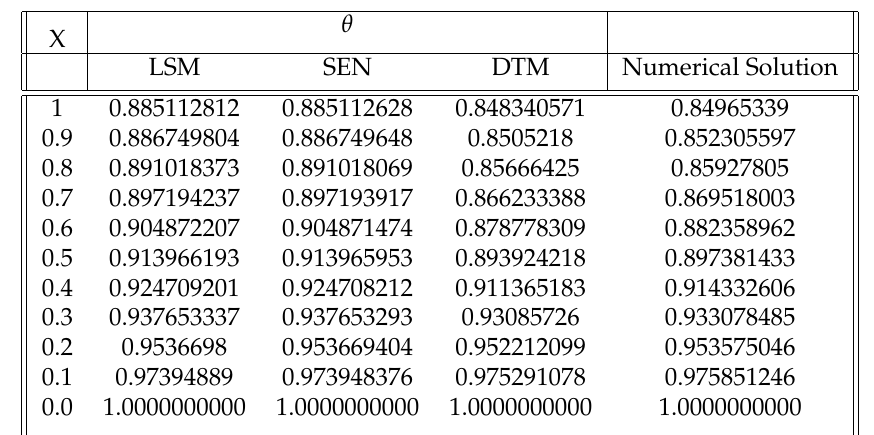
Table 2. Verification of DTM